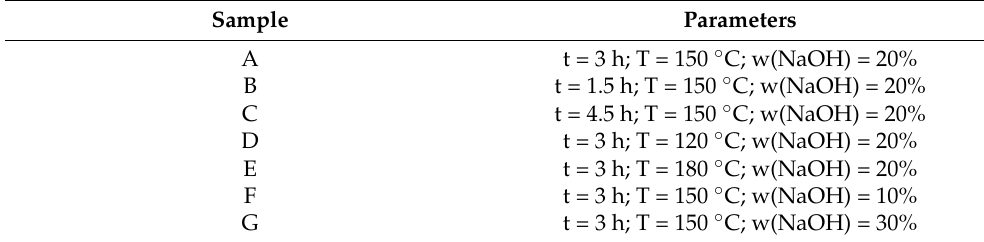
hydrothermal reaction, NaOH